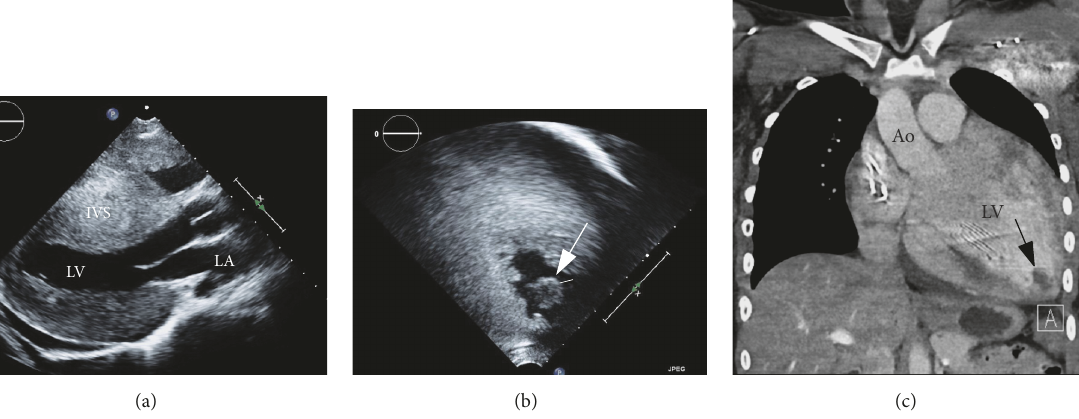
Figure 2: Images of hypertrophic cardiomyopathy (HCM) and a thrombus in the left ventricular (LV) apex. (a) Parasternal long axis view (a) showed severe concentric hypertrophy of interventricular septum (IVS) and LV free wall, but without an echogenic mass in the apex. (b) Off-axis apical four-chamber view identified a round echogenic mass in the LV apex measuring 1.3 × 1.4cm (arrow). (c) A coronal reformat of postcontrast chest CT demonstrated cardiomegaly with an intracardiac thrombus at the LV apex measuring up to 1.8cm (arrow). Ao: aorta, LA: left atrium, and LV: left